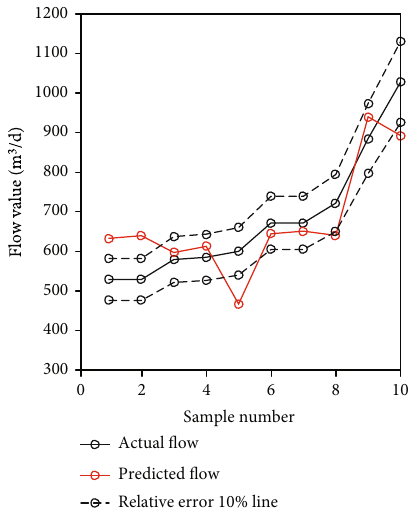
Figure 18: Histogram of the predicted value error of model 1.